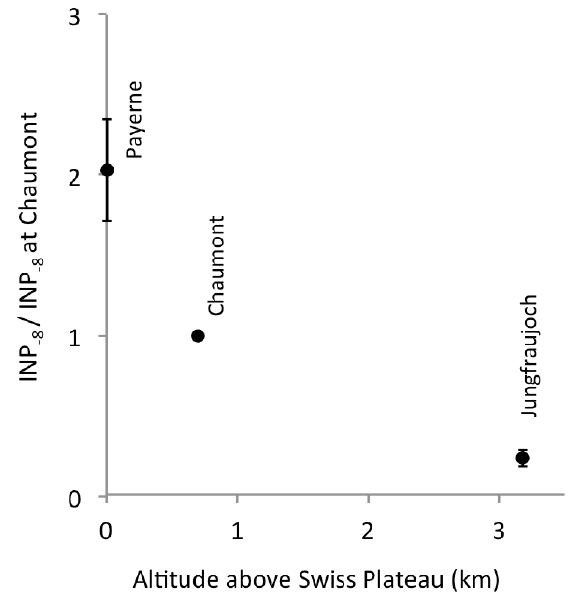
Figure 3. Relation between INP − 8 and altitude above the Swiss Plateau, a low-elevation landscape with productive vegetation. The concentrations of INP − 8 were adjusted to sea level pressure and normalized to the value observed at Chaumont on the same day. Dots represent averages of 26 normalized values; error bars show ±1 standard error.